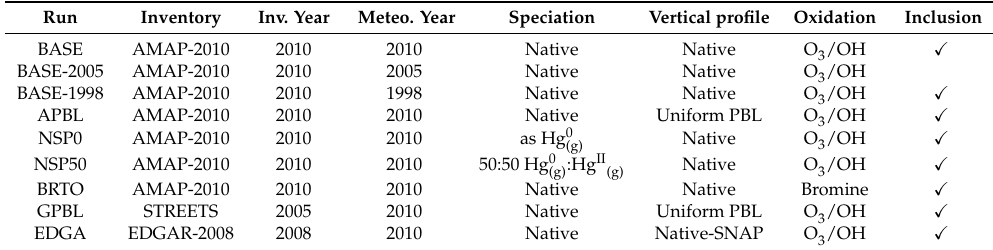
Table 1. The simulations performed. Each simulation of the list represent a reasonable variation of a process or parametrisation regarding the atmospheric cycle of Hg, including inventory, injection height, and speciation of emissions, as well as oxidation mechanism for the nominal year 2010. A check mark in the last column indicates those simulations which were used in the uncertainty analysis. The resulting ensemble represents a reasonable range of the uncertainties in Hg processes and parametrisations, and was used as input to the statistical